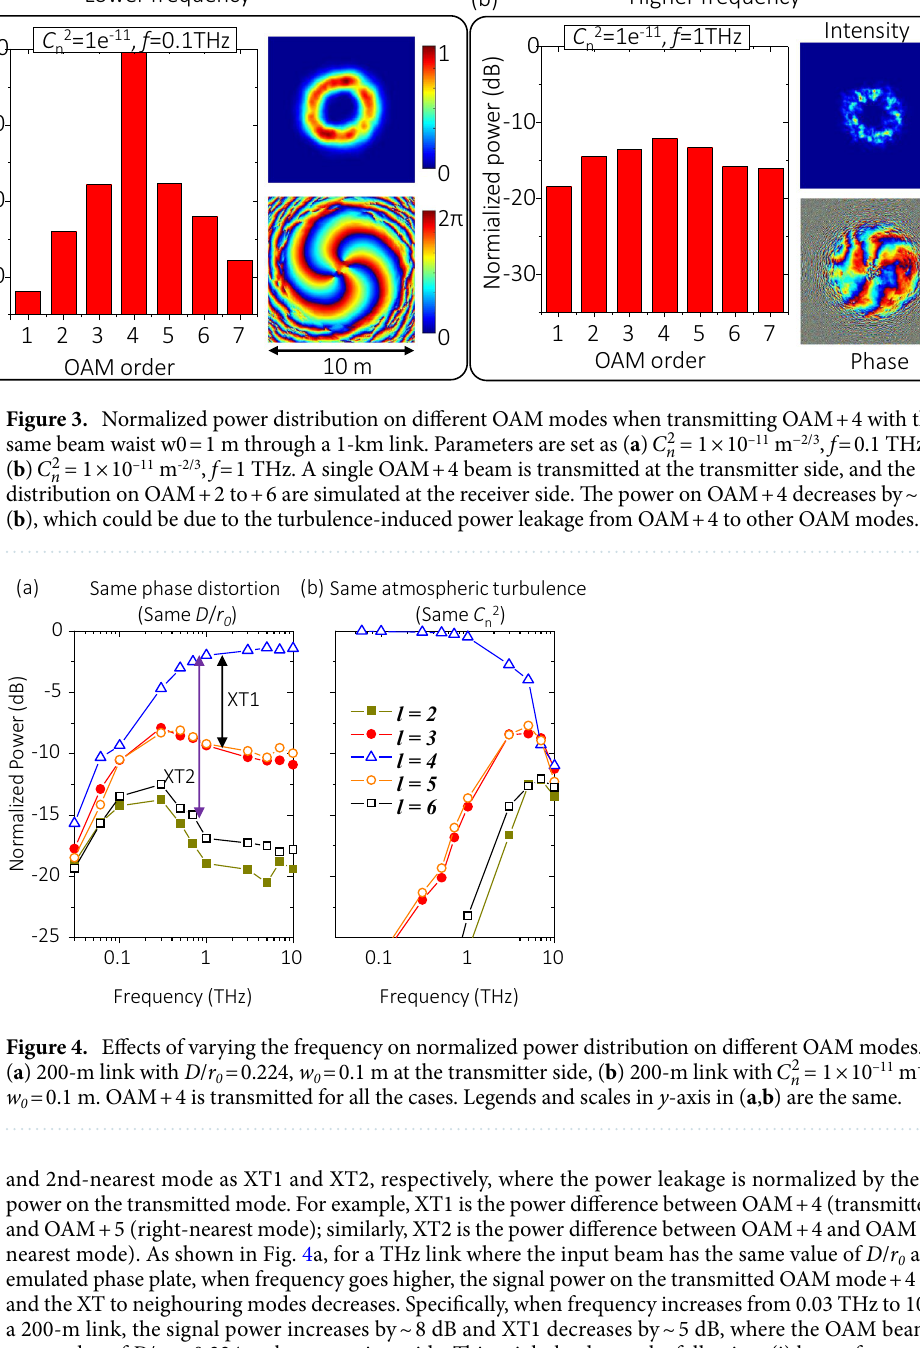
2 n = 1 × 10 –11 m -2/3 ,